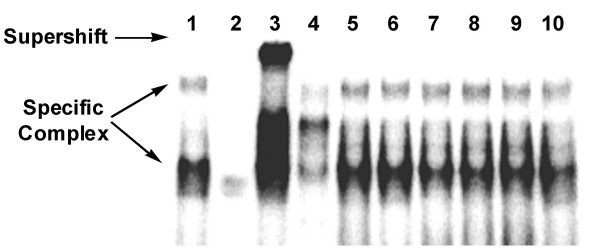
Competition EMSA with recombinant Ets-2 protein and a 32P-labeled ds Ets-2 consensus oligonucleotide. Lane 1: labeled oligonucleotide+Ets-2-GST-fusion protein; lane 2: labeled oligonucleotide+GST protein; lane 3: labeled oligonucleotide+Ets-2-GST-fusion protein+anti-Ets-2 IgG; lane 4: labeled oligonucleotide+Ets-2-GST-fusion protein+unlabeled Ets-2 consensus oligonucleotide (250-fold molar excess); lanes 5–10: labeled oligonucleotide+Ets-2-GST-fusion protein+unlabeled overlapping oligonucleotides from the Tkdp-1 promoter (-150 to +20) at 250-fold molar excess.